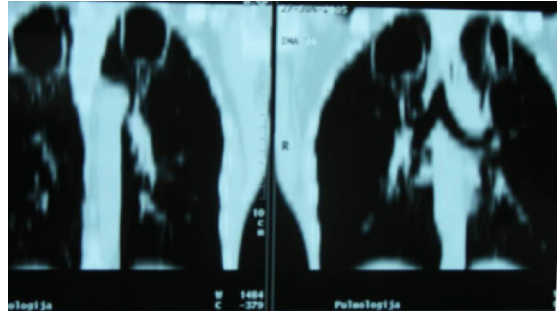
Figure 2. Computed tomography of the lungs pointed to cavern- ous changes in the thick walls that filled both